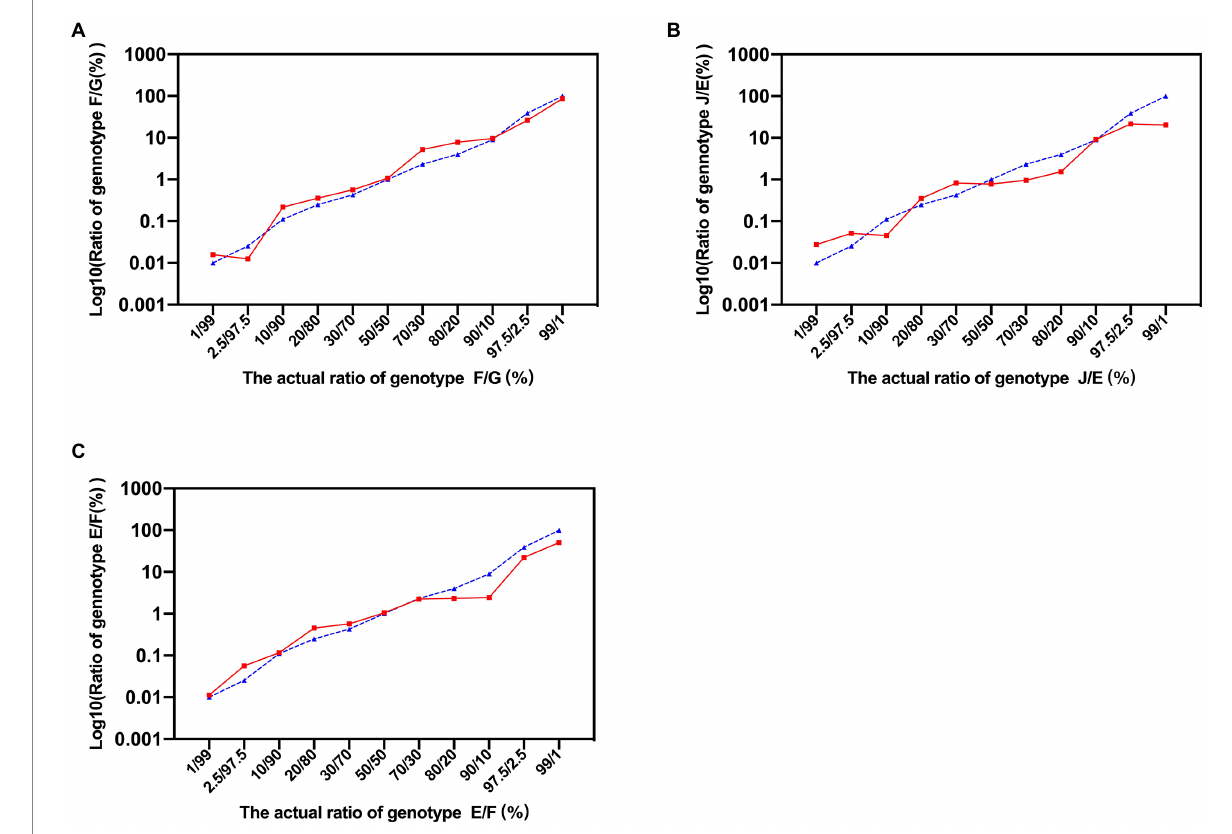
FIGURE 1 Evaluation of next generation high-throughput sequencing (NGHTS) to quantify the composition of different Chlamydia trachomatis genotypes. Plasmid DNAs of different C. trachomatis genotypes F/G (A) , J/E (B) , E/F (C) were mixed at the ratio of 1–99, and were amplified and sequenced. The blue dash line and solid red line represent the ratios of different C. trachomatis genotypes determined by researchers or detected by NGHTS, respectively. The above experiments were repeated twice and the mean values were calculated and